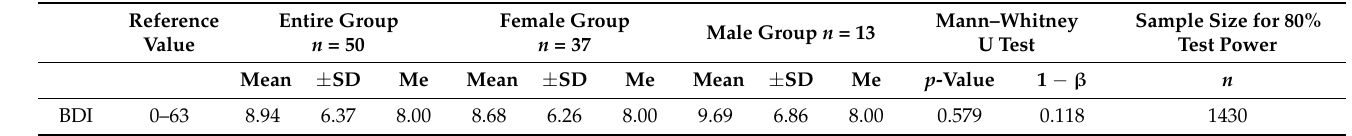
Table 4. Level of depression with respect to the BDI questionnaire in the study group ( n = 50) and for the group of females ( n = 37) and males ( n = 13). Mean standard deviation ( ± SD) and median (Me) are given.